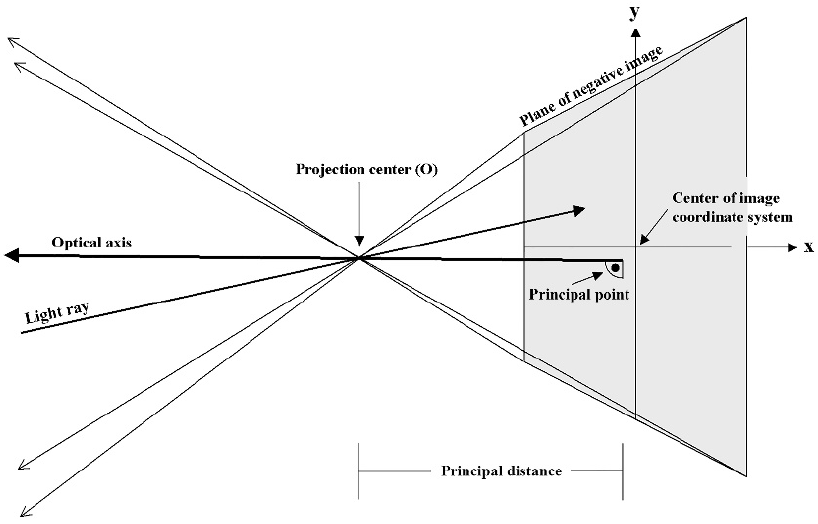
Figure 1. The interior orientation of a camera (illustration by M. Doneus).